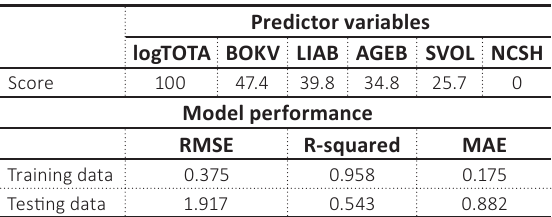
Table 8. Cubist regression approach variable importance scores and performance metrics for EPS model